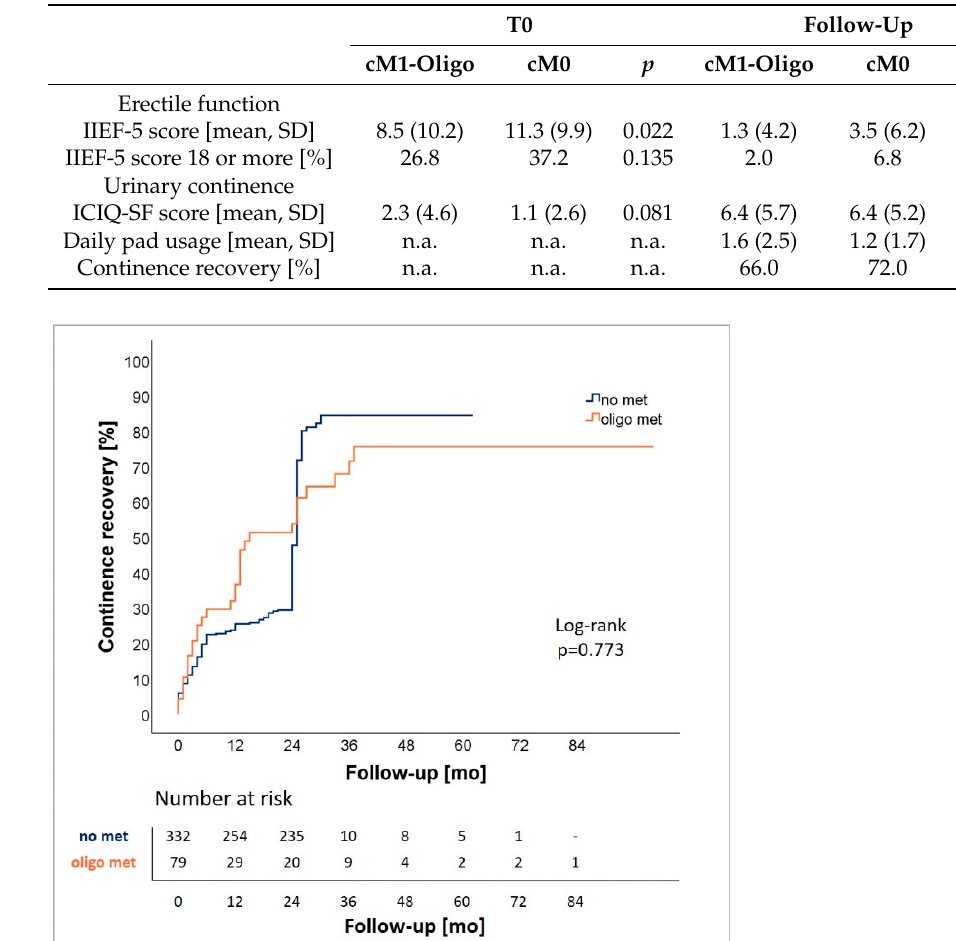
Table 2. Pre- and postoperative functional outcomes after a median follow-up of 25 months. Bold values indicate p- values < 0.05 and were considered statistically significant. Continuous values are presented as median and standard deviation (SD). IIEF-5: International Index of Erectile Function; ICIQ-SF: International Consultation on Incontinence Questionnaire -Short Form.